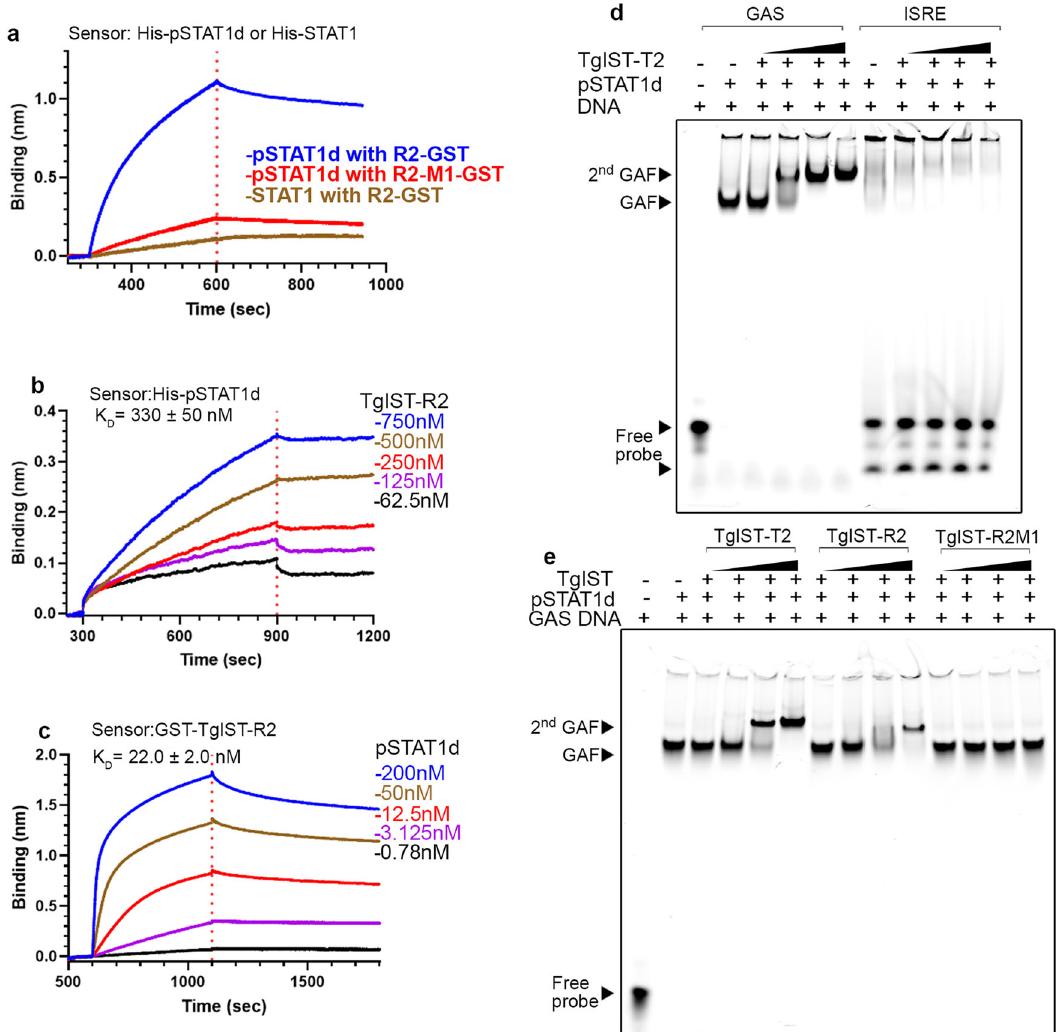
Fig. 4 The repeat region of TgIST binds phosphorylated STAT1 dimers complexed with DNA. a BLI sensorgrams obtained using biosensor loaded with His-tagged pSTAT1 dimer (pSTAT1d, 10 µ g/mL) and incubated with 200 µ M TgIST-R2 (R2-GST) or TgIST-R2-M1 (R2-GST-M1). The red dashed line separates the binding (left) and dissociation (right) phase. The binding of STAT1 monomer to TgIST-R2 (R2-GST) is shown in tan. b BLI sensorgrams using His-tagged recombinant phosphorylated STAT1 dimer (pSTAT1d) immobilized onto Ni-NTA biosensors, followed by incubation in various concentrations of TgIST-R2 after removal of the GST tag. Binding phase (left of the red dotted line) and dissociation phase (right of the red dotted line). c BLI sensorgrams using biosensor loaded with recombinant GST-tagged GST-TgIST-R2 and interacted with different concentrations of pSTAT1d. Binding phase (left of the dotted red line) and dissociation phase (right of the red dotted line). d Electromobility shift assays (EMSA) demonstrating TgIST-T2 binds to pSTAT1d associated with GAS DNA oligonucleotide but not to ISRE oligonucleotide. See also Supplementary Fig. 7 for unlabeled competitor assays. Puri fi ed pSTAT1 dimer was incubated with far-red fl uorescence IRDye labeled double-stranded oligonucleotides, puri fi ed TgIST-T2 was then added, followed by a native polyacrylamide gel analysis. Visualization was performed using an Odyssey infrared imager. GAF refers to gamma-interferon activation factor composed of pSTAT1 and the labeled GAS DNA probe, 2nd GAF refers to GAF further complexed with TgIST-T2 resulting in a higher molecular weight complex. Black triangles indicate increasing concentration of TgIST-T2. e Formation of the 2nd GAF complex is dependent on the repeats in TgIST-R2. STAT1 dimer and GAS oligonucleotide complexes were made as in ( d ) but in addition to the T2 construct (TgIST-T2), GST-tagged TgIST-R2, or the mutated version TgIST- R2-M1, were also tested. GST was used as the af fi nity tag for puri fi cation and to increase the molecular weight in of TgIST-R2 to visualize R2-mediated super shift. See Supplementary Fig. 7 for GST alone control. Black triangles indicate increasing concentration of components added based on label at the top. Representative gel image ( d , e ) of two independent experiments with similar results were shown here. Source data are provided in the Source Data fi